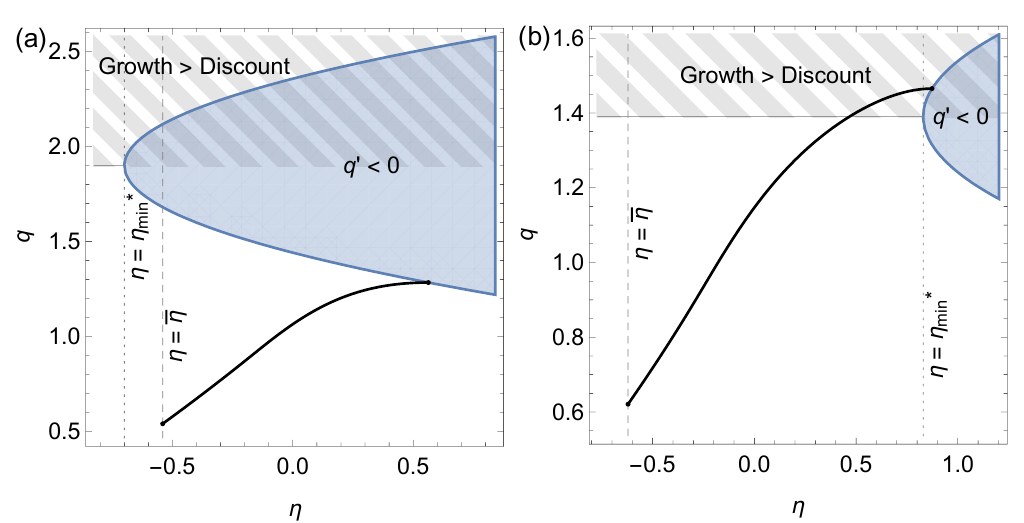
Figure A1. Illustration of Proof of Proposition 2. In subfigure ( a ), the "no-Ponzi" condition, Equation (A15), holds: the initial η is below the dividend paying boundary, and so the solution is guaranteed to hit it. Subfigure ( b ) shows a scenario wherein the condition does not hold: The solution starts from a point to the left of η ∗ , and grows fast enough to miss the lower branch of min q (cid:48) = 0 curve, entering a region where growth exceeds the discount rate. In ( a ), parameters are set to baseline, ρ = 0.06, r = 0.05, σ 1 = 0.2, σ 2 = 0.0, a = 0.1, ¯ a = 0.04, δ = 0.02, θ = 15 and χ = 0.75; in ( b